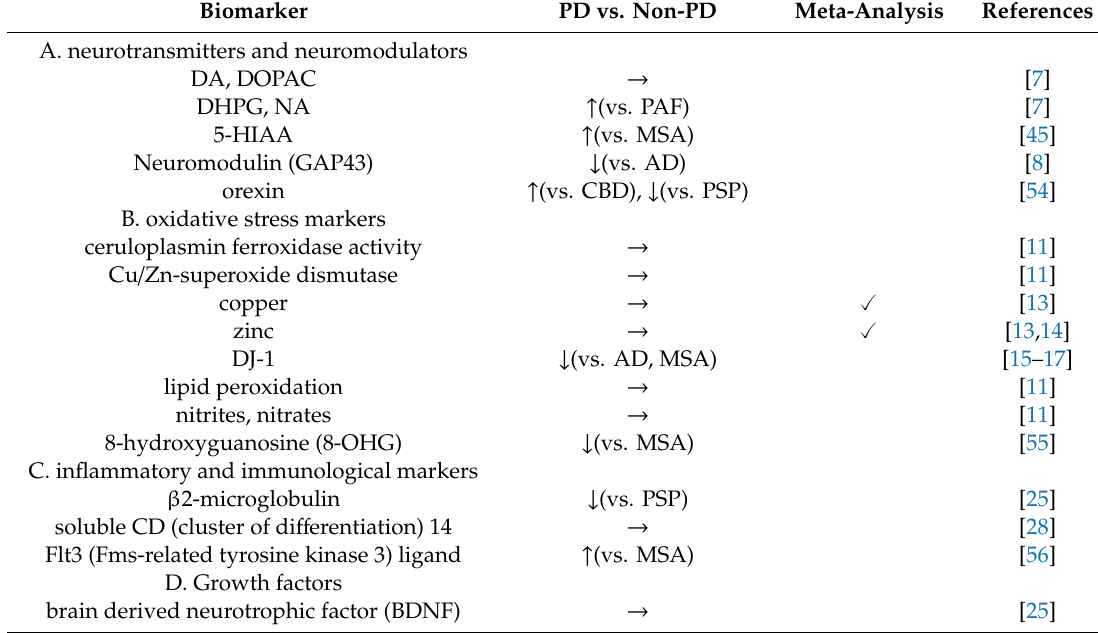
Table 2. Candidate cerebrospinal fluid biomarkers for distinguishing Parkinson’s disease.